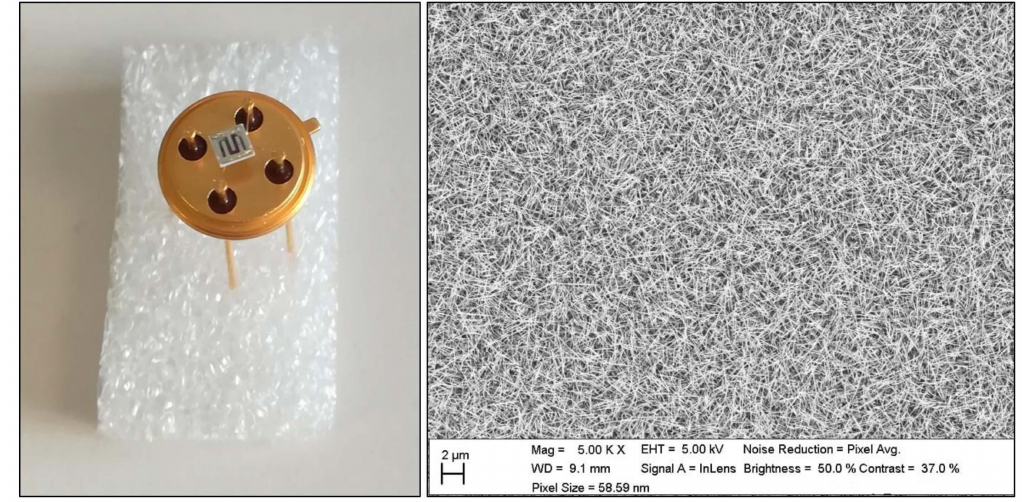
Figure 5. On the left, an image of a SnO 2 Au nanowire sensor with its support. On the right, a SEM image of the same sensor where the nanowires are